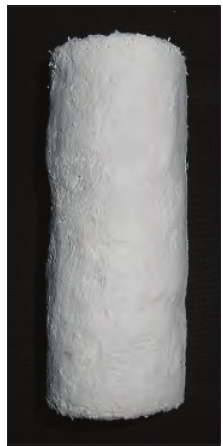
Figure-2: Plaster of Paris bandage cast.